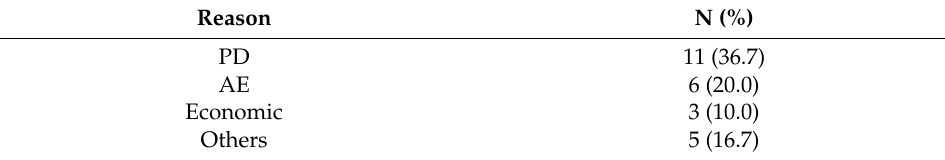
Table 5. Reasons for discontinuation.